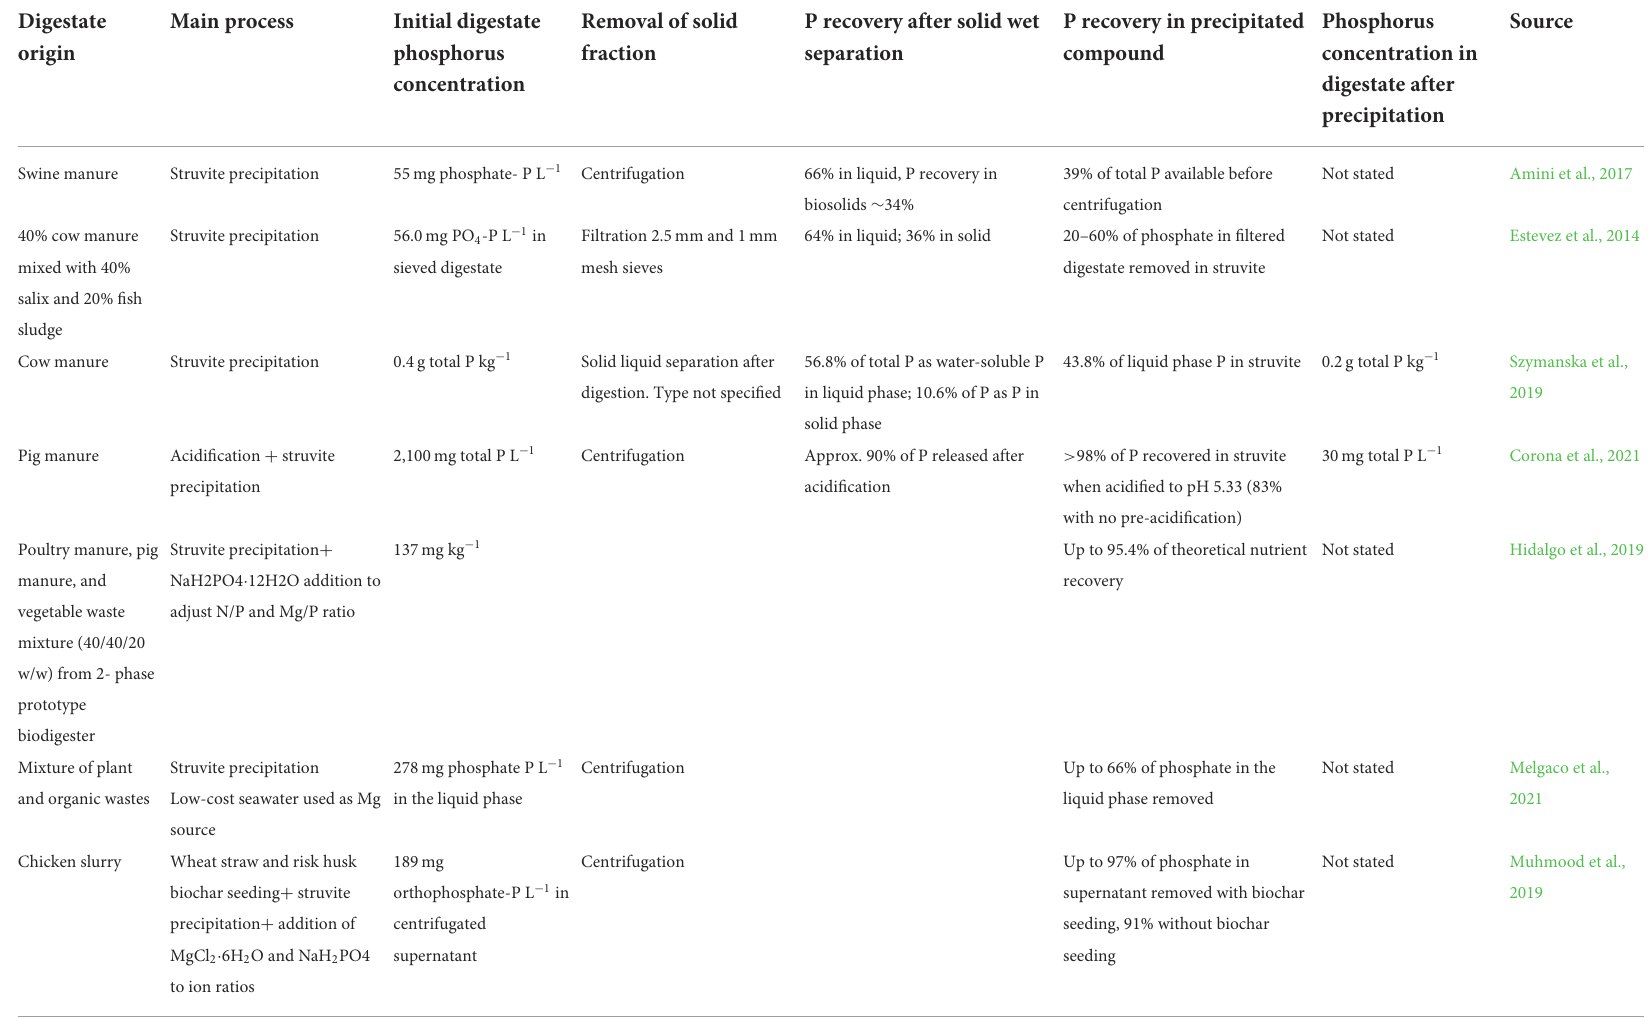
TABLE 1 Phosphorus (P) retention in experiments on precipitation of struvite and calcium phosphates from manure-based